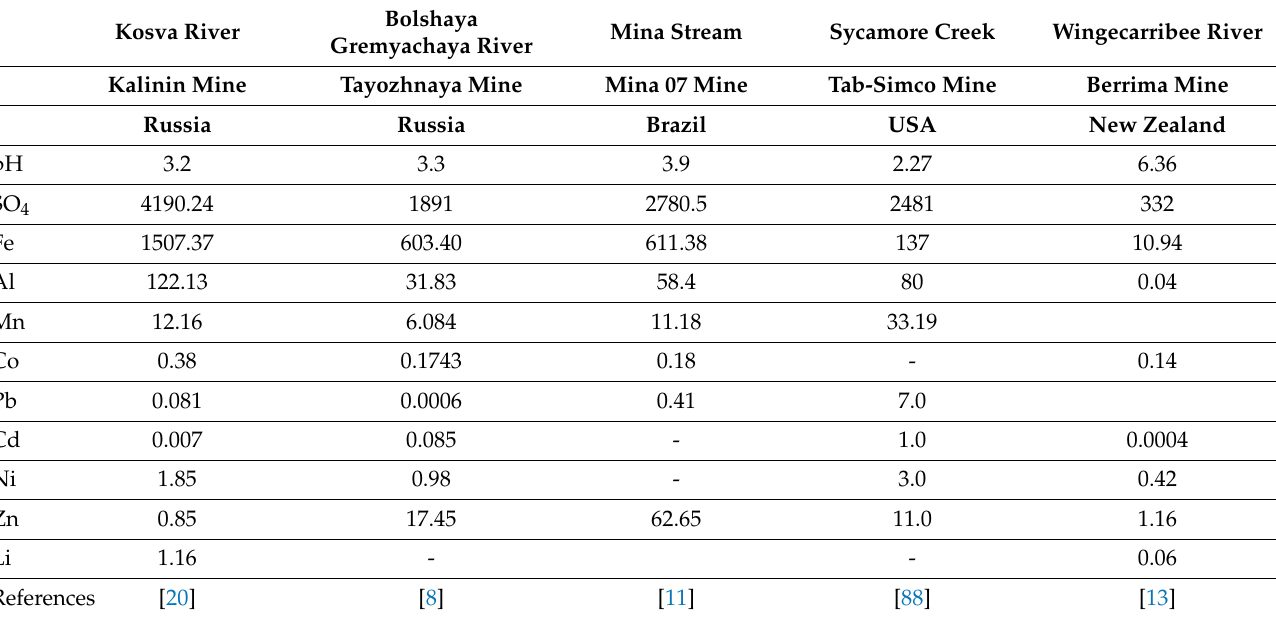
Table 10. Integrated data by Characterization of Raw AMD